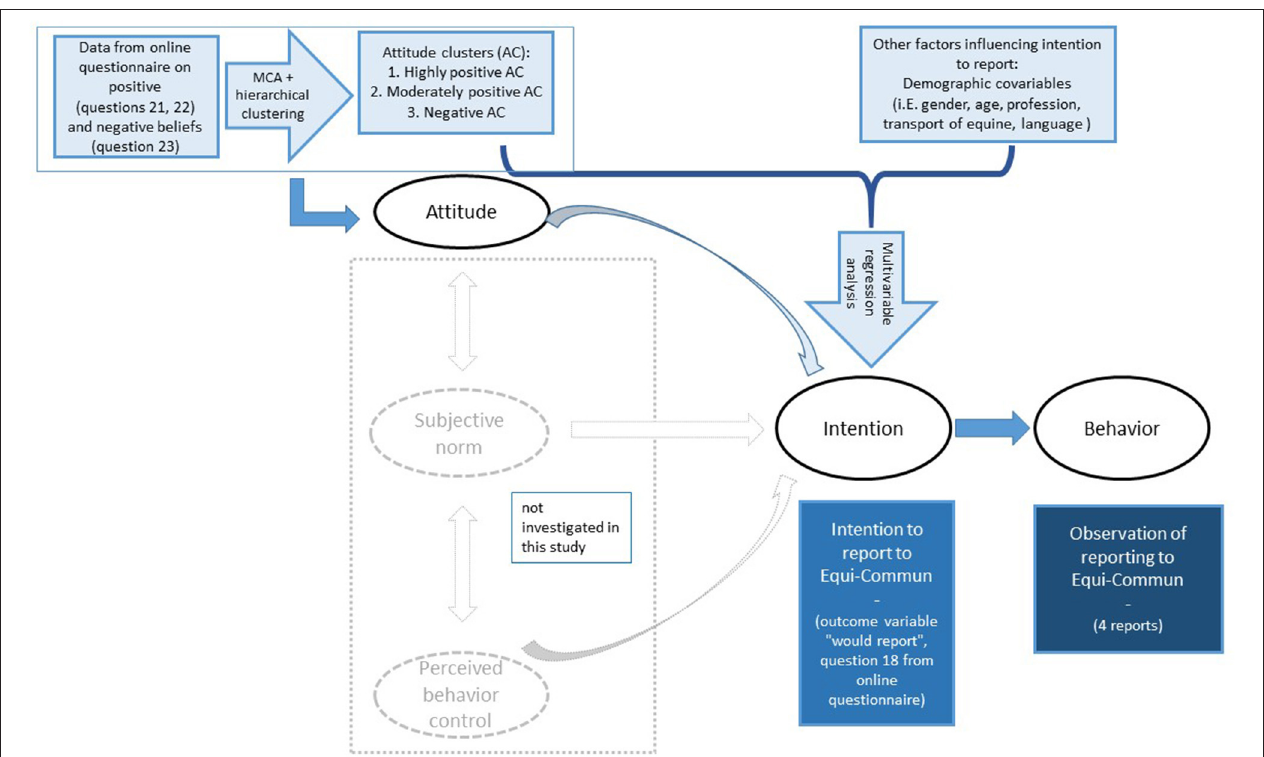
FIGURE 1 | Framework of the Theory of Planned Behavior (TPB) by Ajzen (43) adapted to investigate factors influencing the intention and observed behavior to report to the CBS tool Equi-Commun.